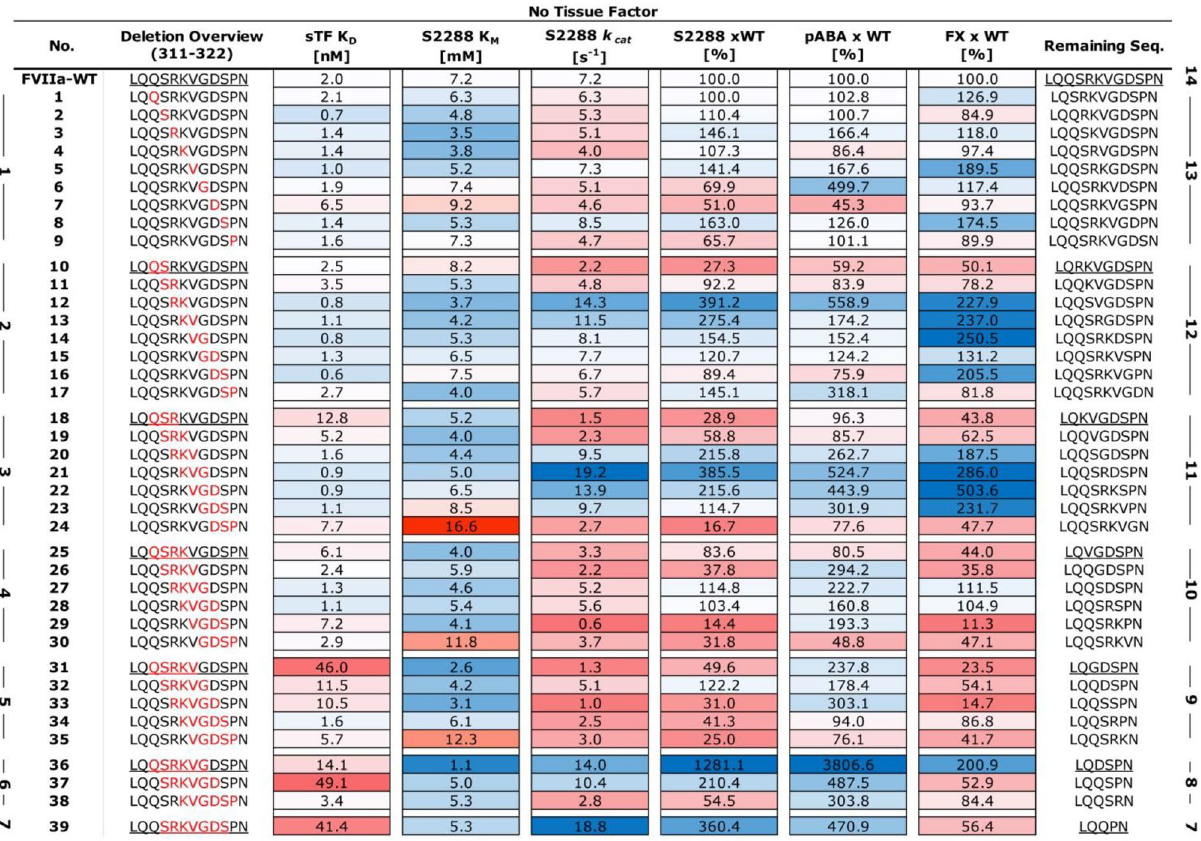
Figure 2. Heatmap of Functional FVIIa Variant Characterization. Soluble tissue factor (sTF) binding as K d [nM], amidolytic activity as K M [mM], k cat [s −1 ] and percentage k cat / K M compared to FVIIa, pABA inhibition as percentage K i of FVIIa and Factor X activation as percentage of FVIIa. More active or stronger binding variants are shown in blue and less active or weaker binding variants in red. All data is shown as the mean of duplicate runs without sTF. Variants are sorted by loop length and deletion position (in red) with the start of each sliding window underlined and the resulting loop length listed. (right bold numbering), the number of deleted residues is show on the